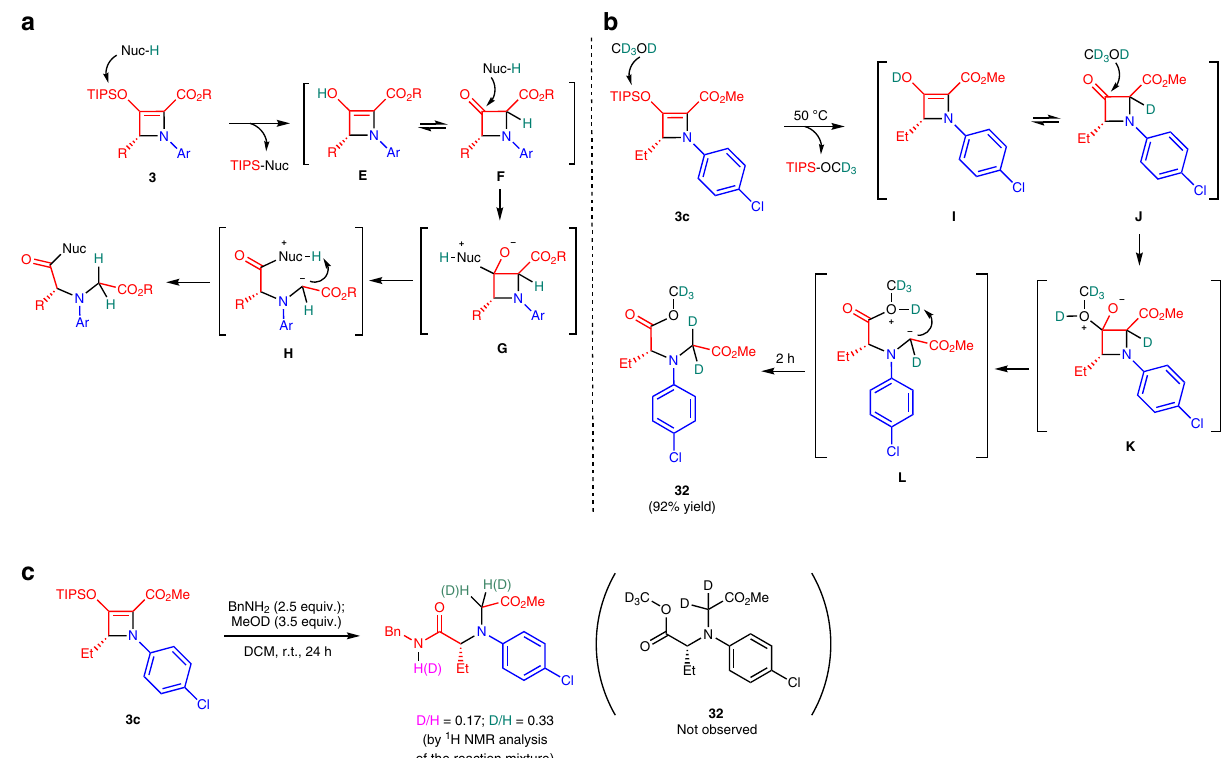
Fig. 4 Mechanistic studies. a Proposed mechanism for nucleophilic ring opening of 2-azetine-2-carboxylates 3 . b Deuterium incorporation experiment. c Proton – deuterium exchange with MeOD.